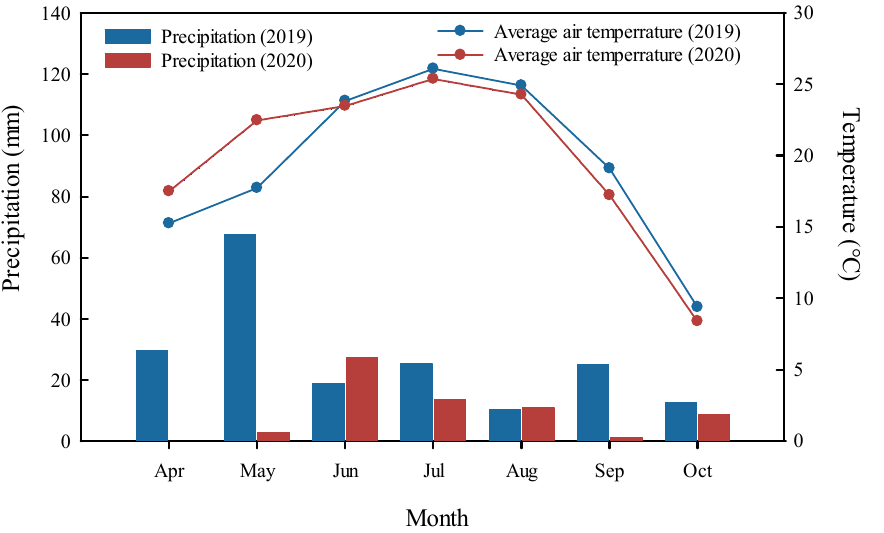
Figure 1. Average monthly precipitation (mm) and air temperature (°C) in the 2019 and 2020 cotton- growing seasons.